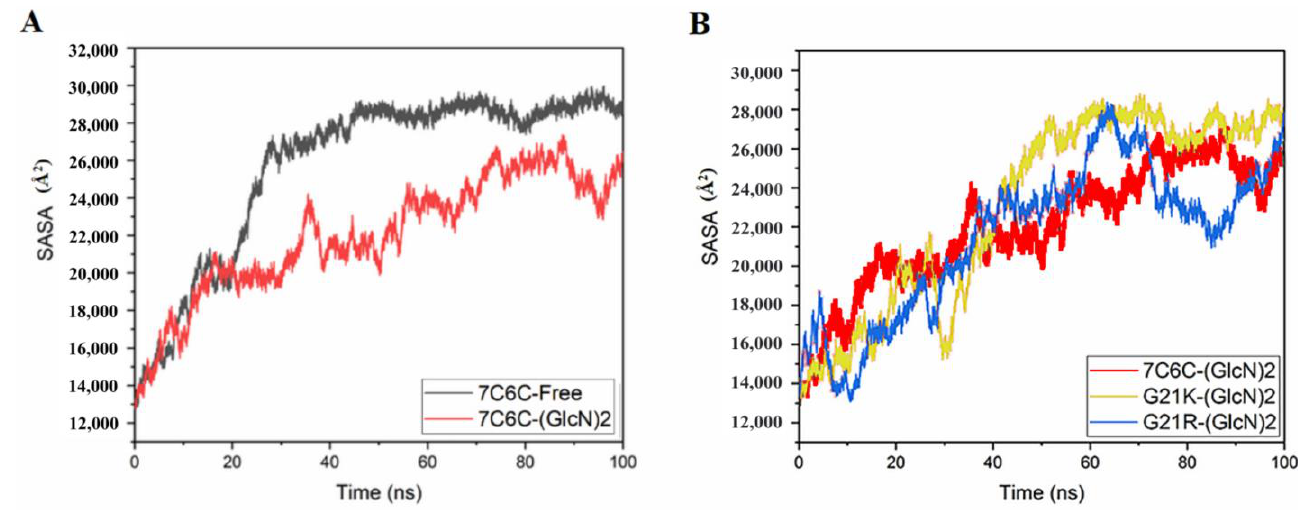
Figure 4. SASA plots. ( A ) 7C6C-free (black) and 7C6C-(GlcN) 2 (red); ( B ) 7C6C-(GlcN) 2 (red), G21K- (GlcN) 2 (yellow) and G21R-(GlcN) 2 (blue).